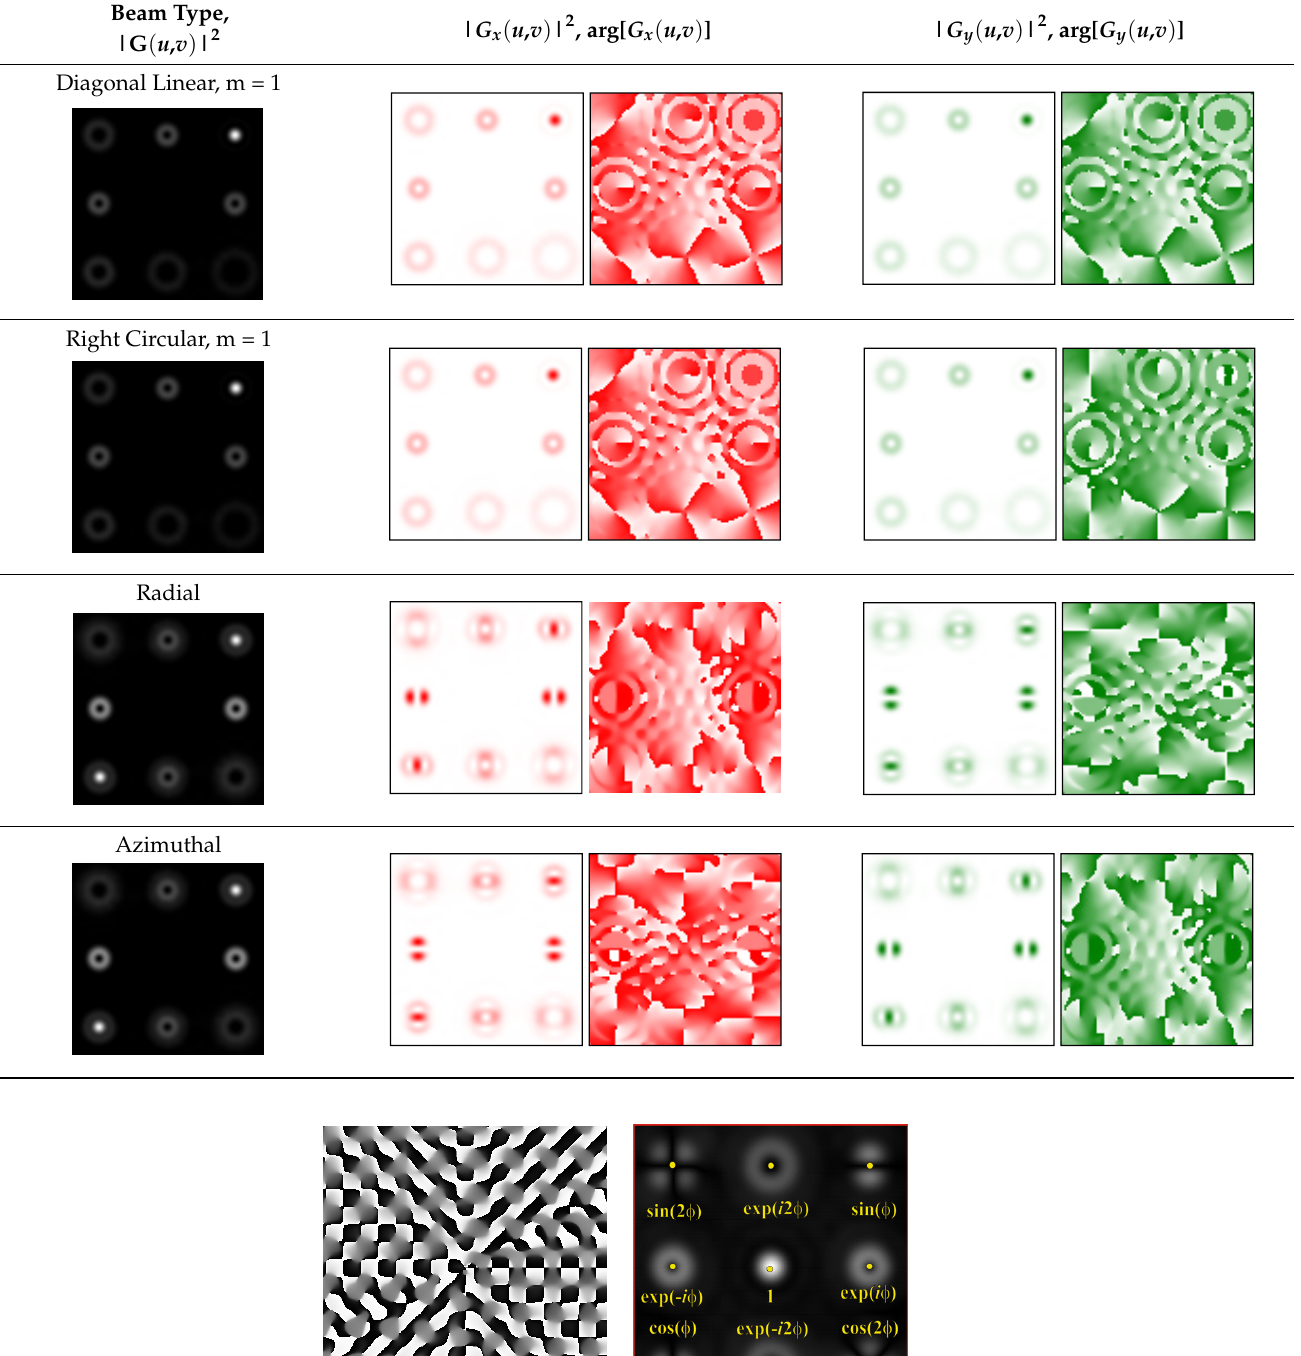
Table 4. Field distribution in the focal plane for beams with different polarizations when using a filter with vortex orders.